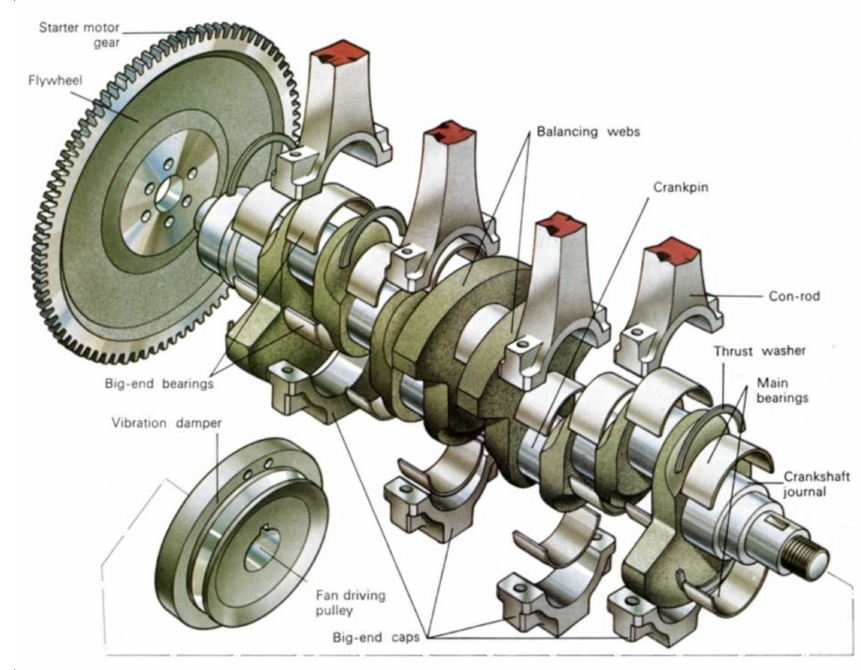
Figure 18. Applications of flywheels in vehicles, adapted from